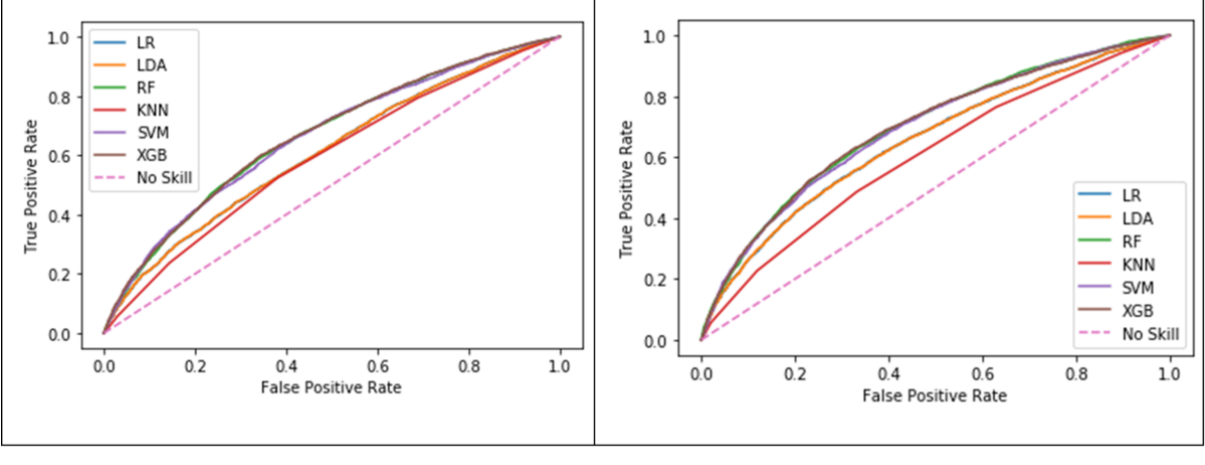
Figure 9. Comparison of receiver operating characteristic curves in the length of stay model using the baseline (left) and quantiles (right) approaches. LR: logistic regression; LDA: linear discriminant analysis; RF: random forest; KNN: k-nearest neighbor; SVM: support vector machine; XGB: extreme gradient